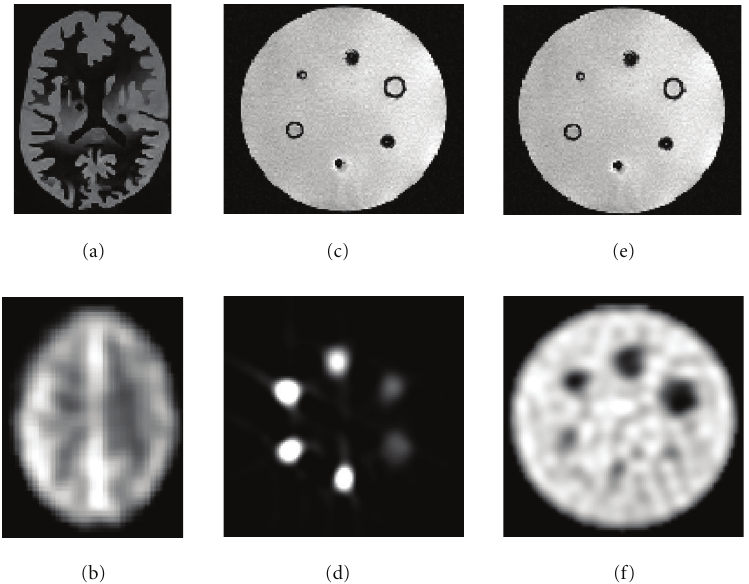
Figure 1: Transaxial slices of the phantoms. (a) Ho ff man phantom MRI. (b) Ho ff man phantom SPECT. (c) Cylindrical phantom MRI. (d) Cylindrical phantom SPECT with hot spheres. (e) Cylindrical phantom MRI. (f) Cylindrical phantom SPECT with cold spheres.